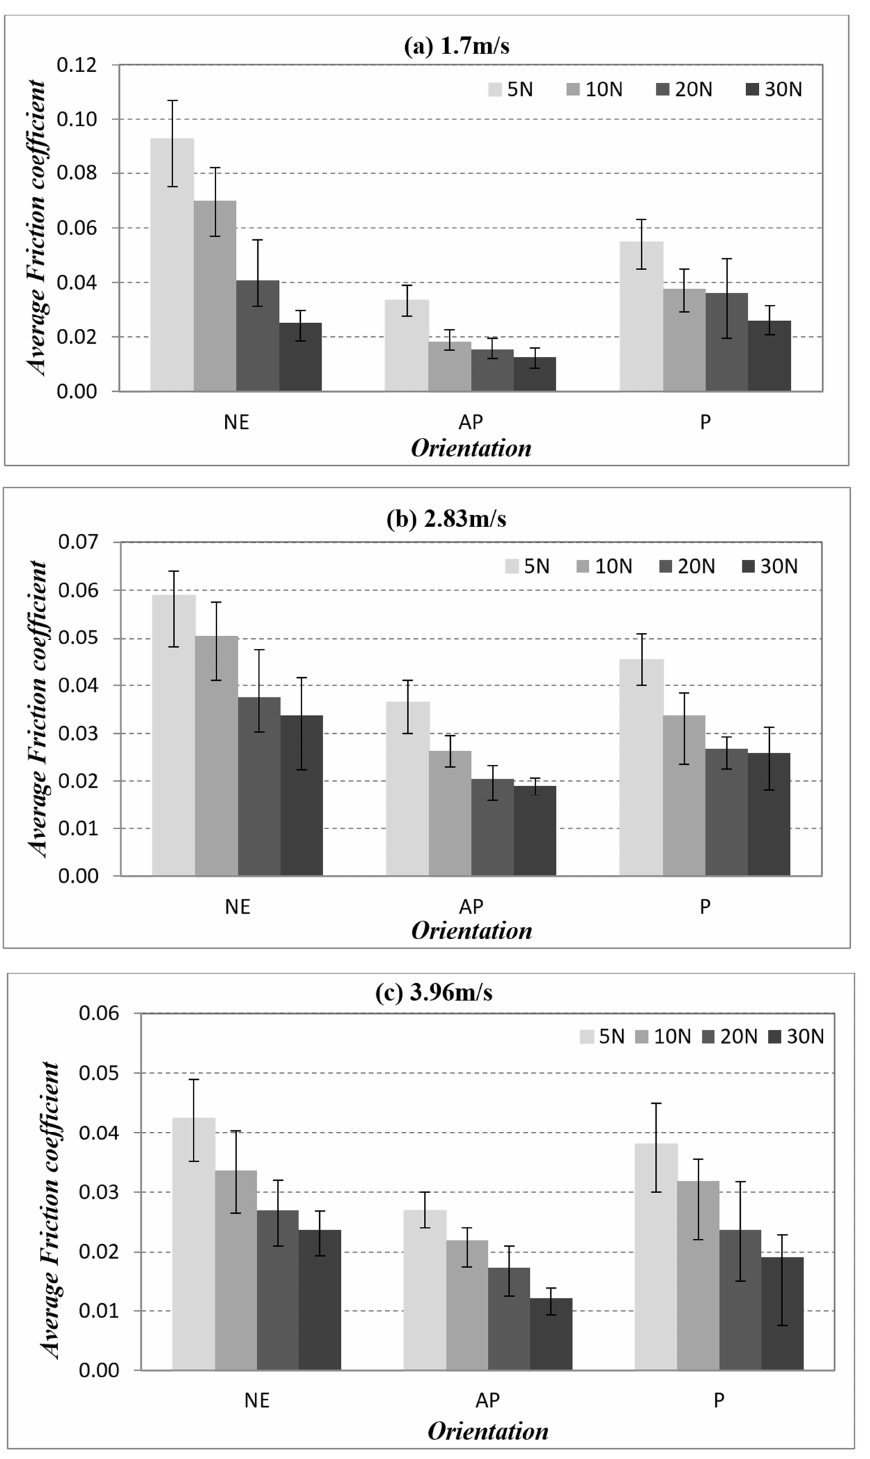
Figure 9. Friction coefficient for different fibre orientation (AP and P) and neat epoxy subjected to different of applied normal load at different of sliding